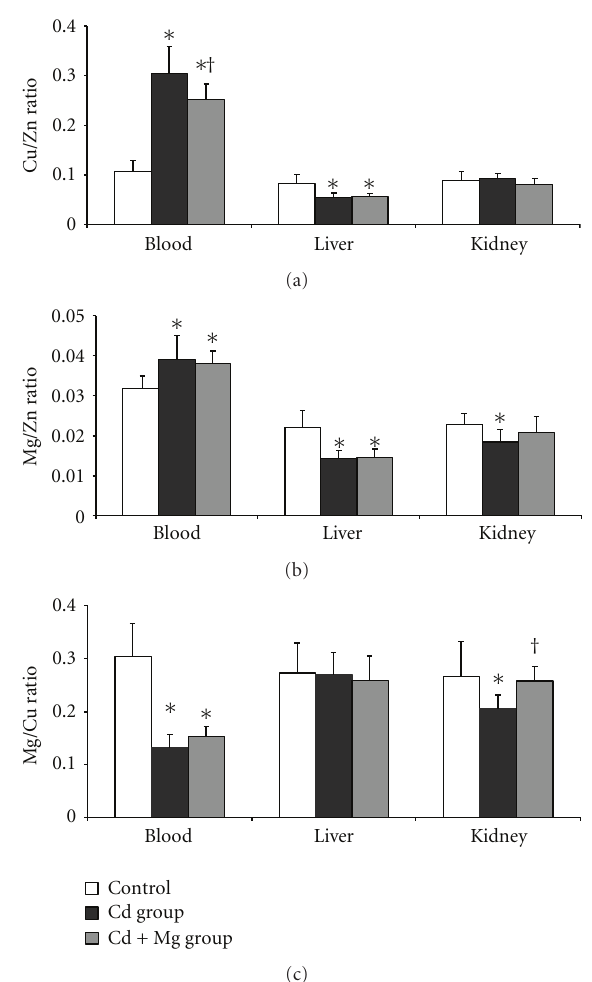
Figure 2: E ff ect of Cd exposure and Mg supplementation on Cu/Zn ratio (a), Mg/Zn ratio (b), and Mg/Cu ratio (c) in blood, liver, and kidney of rabbits. Control group: nontreated animals. Cd group intoxicated orally for 4 weeks with 10mg Cd/kg b.w./day. Cd + Mg group given 40mg Mg/kg b.w. 1h after Cd treatment. Marked values di ff er significantly (ANOVA + LSD test) from ∗ control and † Cd group ( P < 0 .